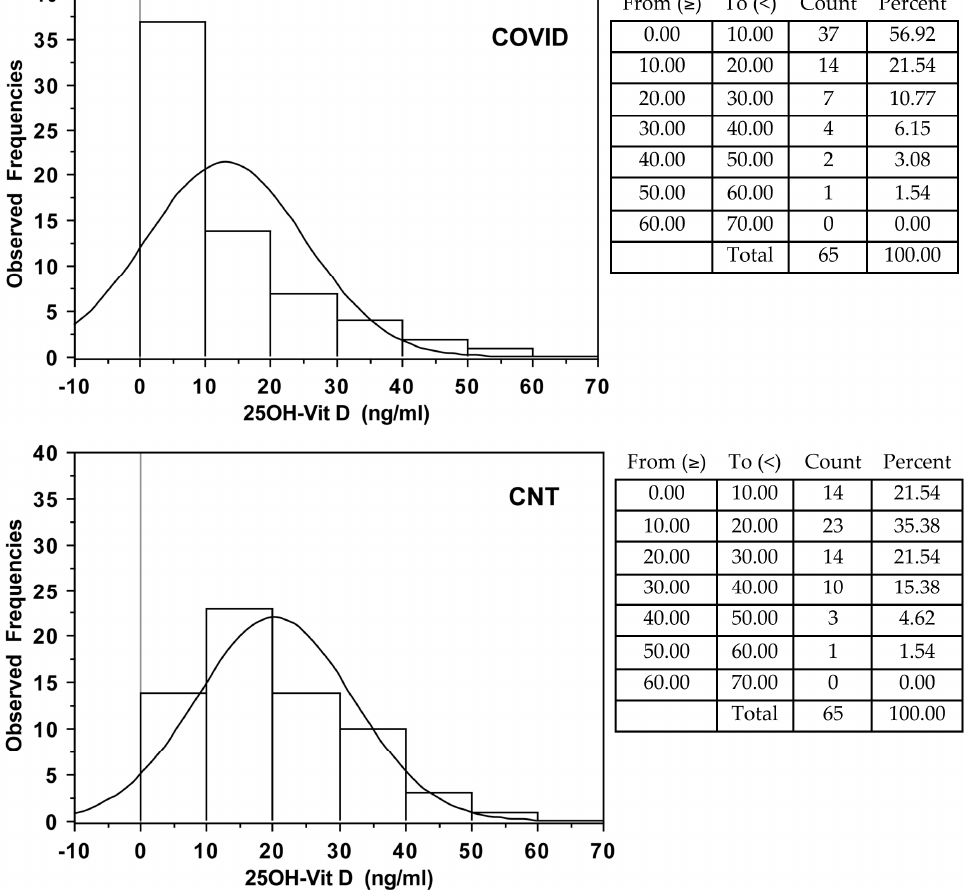
Table 4. Multiple linear regression results showing the statistically significant associations be- tween vitamin D serum levels (25OHD) and both PaO 2 /FiO 2 ratio and PaO 2 . Outcome Predictors